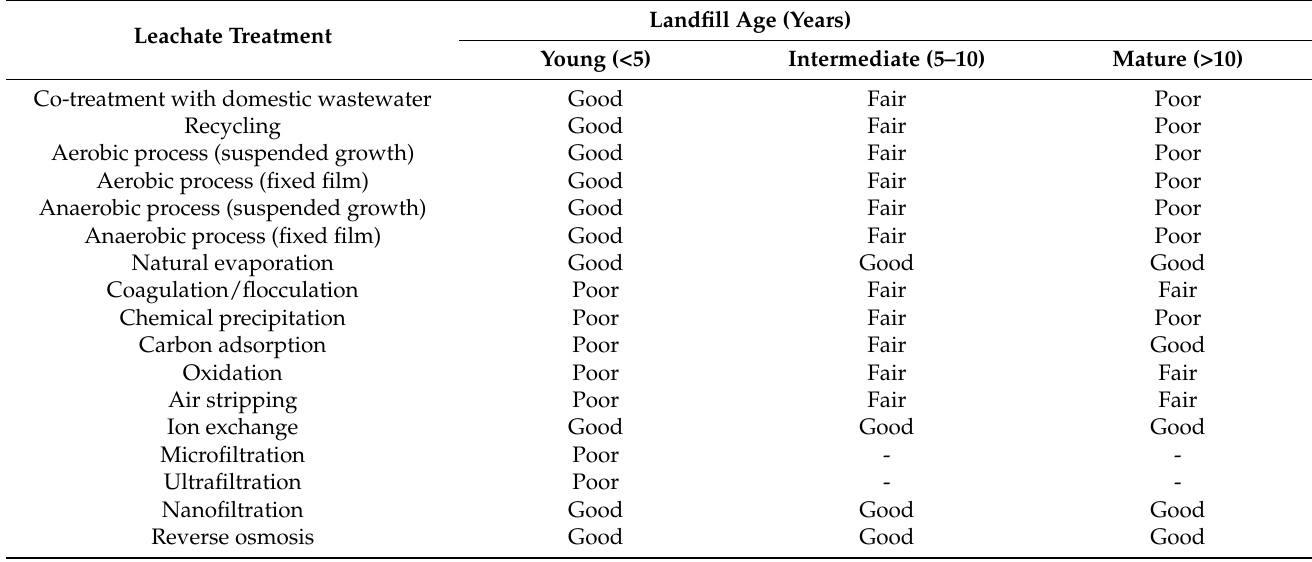
Table 2. Options for treating leachate based on landfill age.